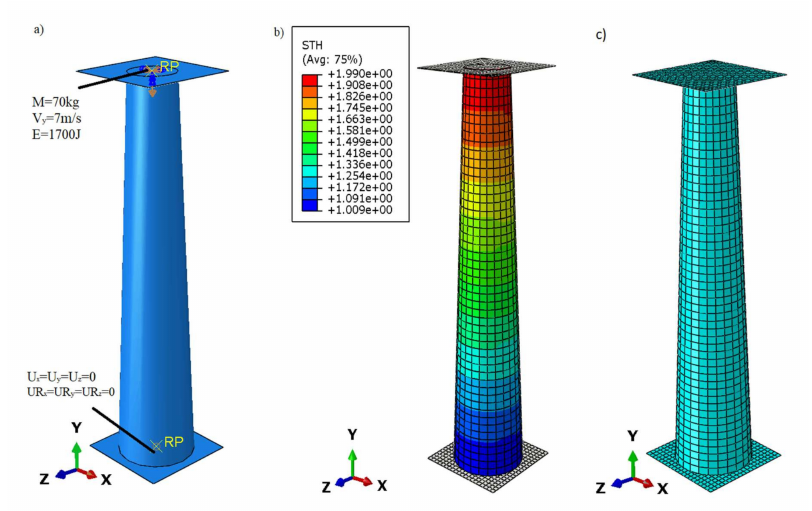
Figure 5. ( a ) Boundary constraints defined in finite element analysis; ( b ) the variable wall thickness of the tested profile; ( c ) discrete numerical model.